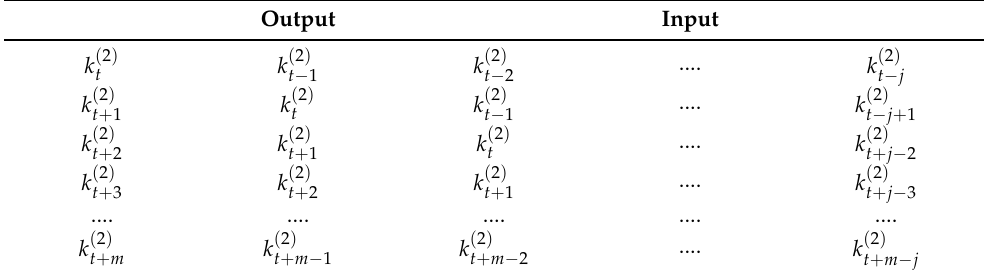
Table 1. Supervised Learning DataSet.